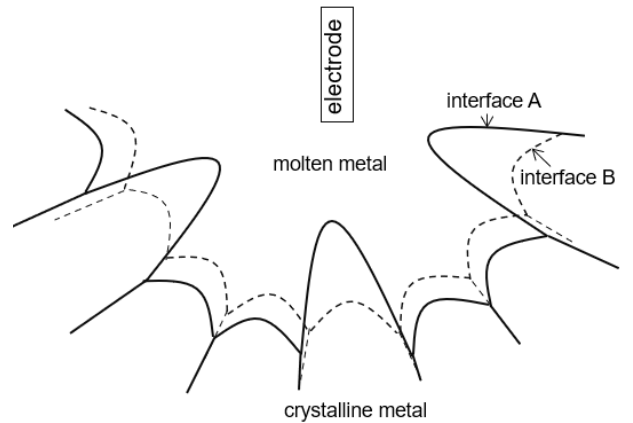
Figure 2. The schematic diagram shows the grain growth under the electric effect (interface A) and under the heat effect (interface B). under the heat effect (interface